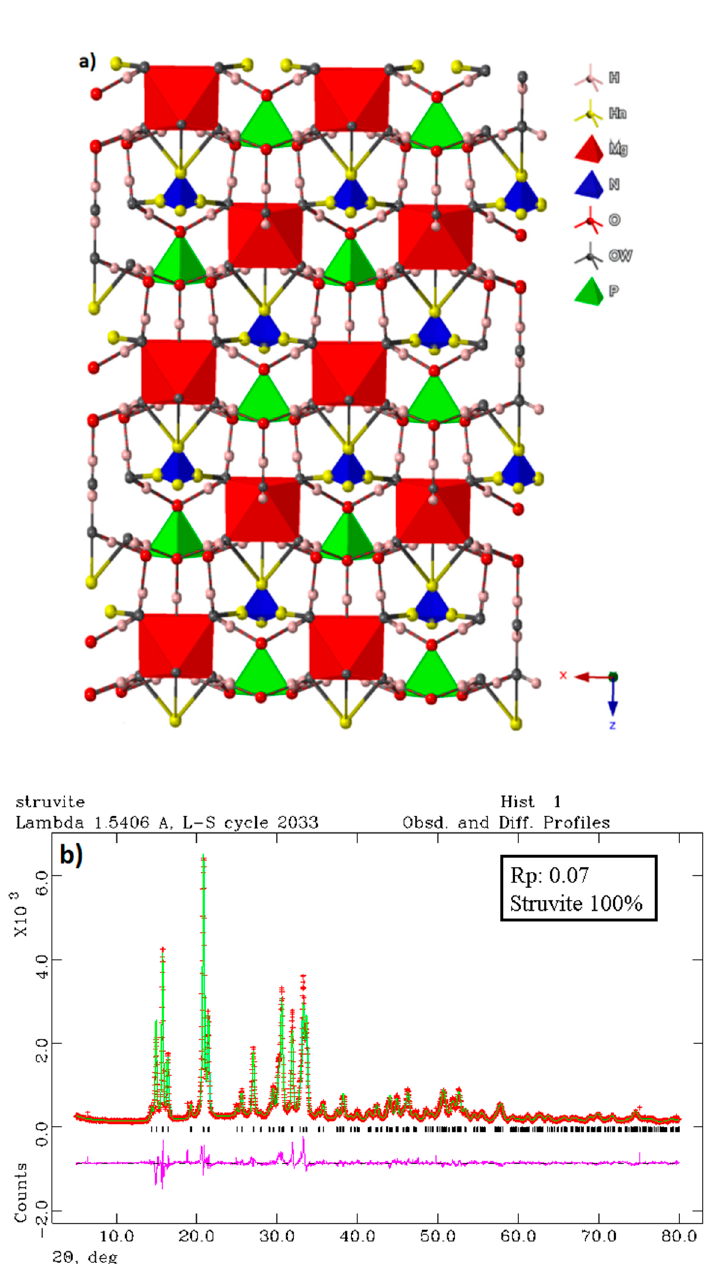
Figure 3. ( a ) Crystal structure of struvite projected along the x axis. In blue, the ammonium tetrahedra, in green, the phosphorous tetrahedra and in red, the magnesium octahedra are reported. The sticks represent the OH…O and NH---O hydrogen bond systems. ( b ) The X-ray diffraction spectrum of the sample refined with the Rietveld method [50], using GSAS EXPGUI [51,52] software, indicates that only struvite is present.